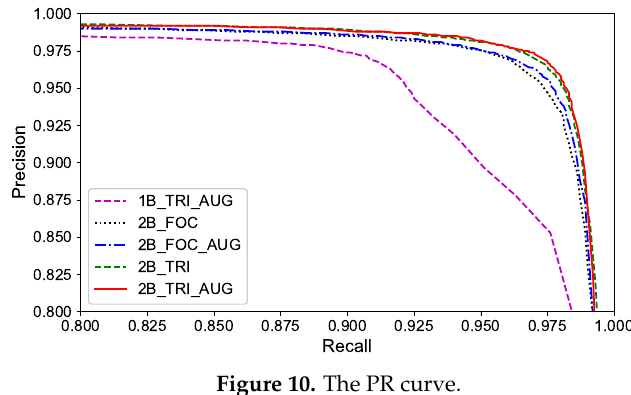
Figure 10. The PR curve. Table 2. Precision of compared methods with baselines under different environmental